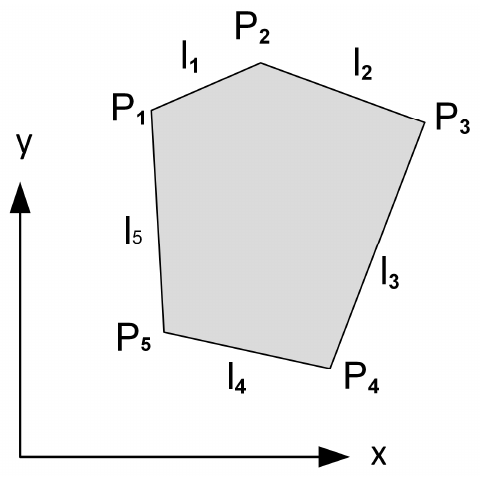
Figure 6. Closed polyline with five vertices (P k ) and straight line segments (l i ).